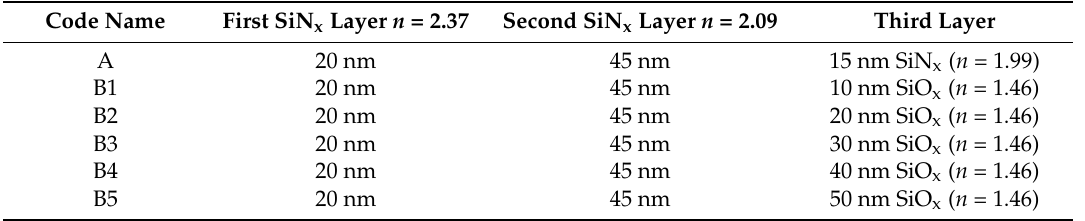
Table 1. The simulation parameters of the triple-layer antireflection coating of monocrystalline silicon PERC solar cells in